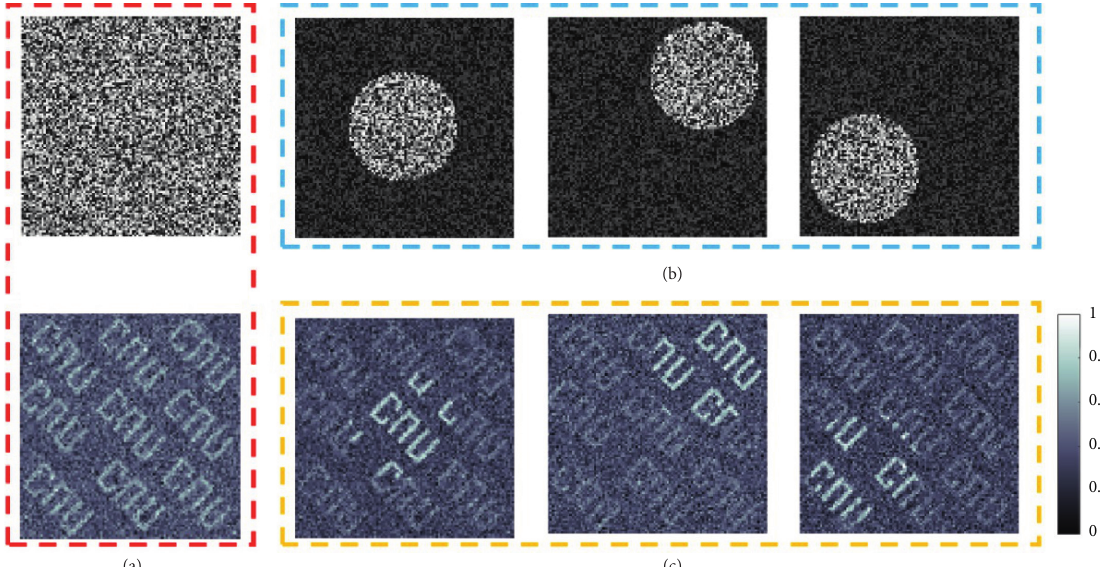
Figure 7: A set of simulation results of different ROIs using the proposed method. (a) The original speckle patterns and the imaging results (10,000 measurements). (b) The speckle patterns with uneven light intensity in different ROIs. (c) Imaging results (10,000 measurements, r � 3) corresponding to the speckle patterns in